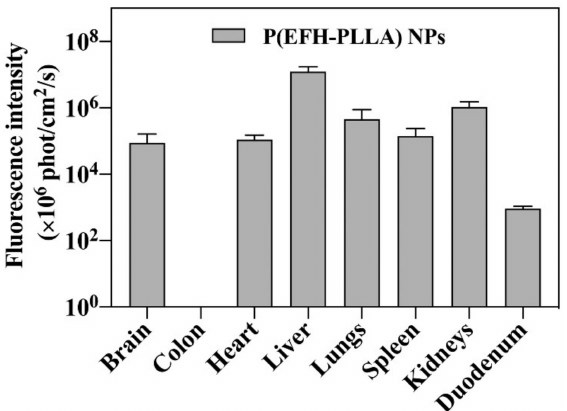
Figure 6. Biodistribution of P(EFH-PLLA) NPs. One hundred µ L of Cy7-conjugated NPs (0.2 mg / mL) were injected IV via the tail vein. Mice were sacrificed 4 h post injection, and organs were